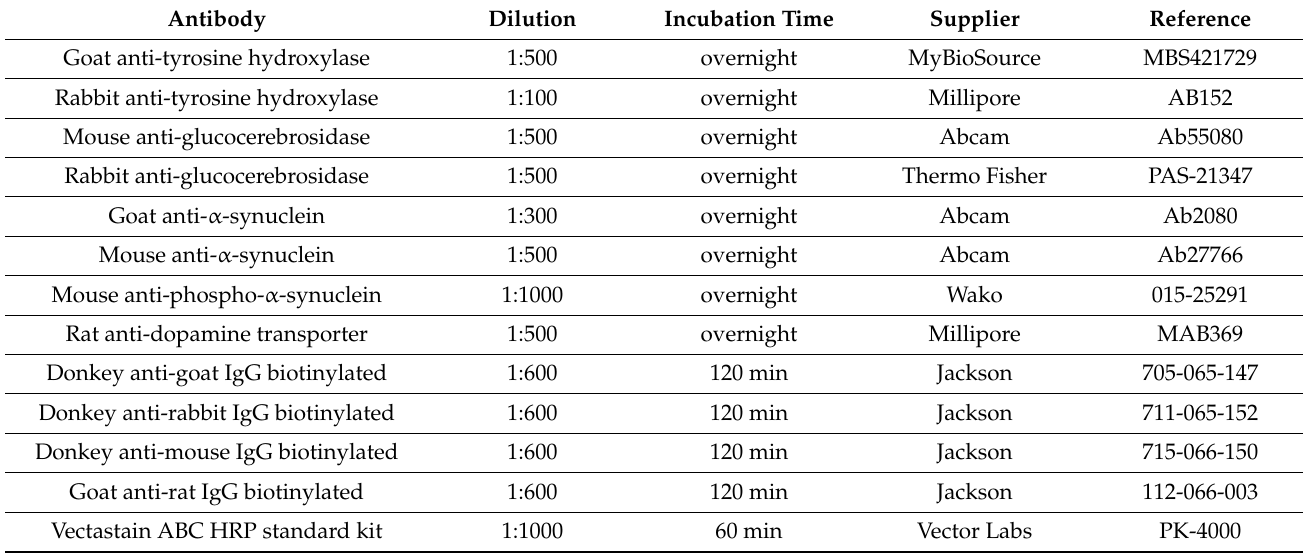
Table 2. List of primary and secondary